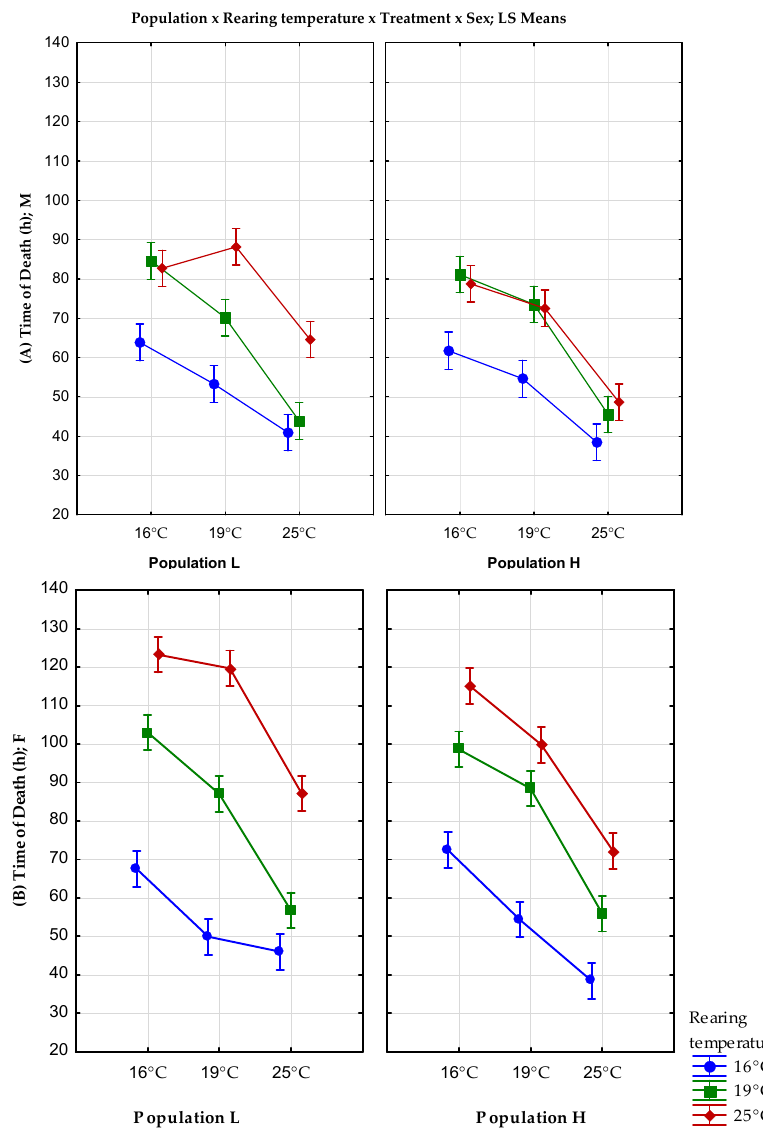
Figure 3. Results of the full factorial GLM analysis of starvation resistance with fixed factors population, rearing temperature, treatment temperature, and sex; ( A ) males; and ( B ) females. Vertical bars denote a 0.95 confidence interval. M—males; F—females; L—population originating from lower altitude; H—population originating from a higher altitude.